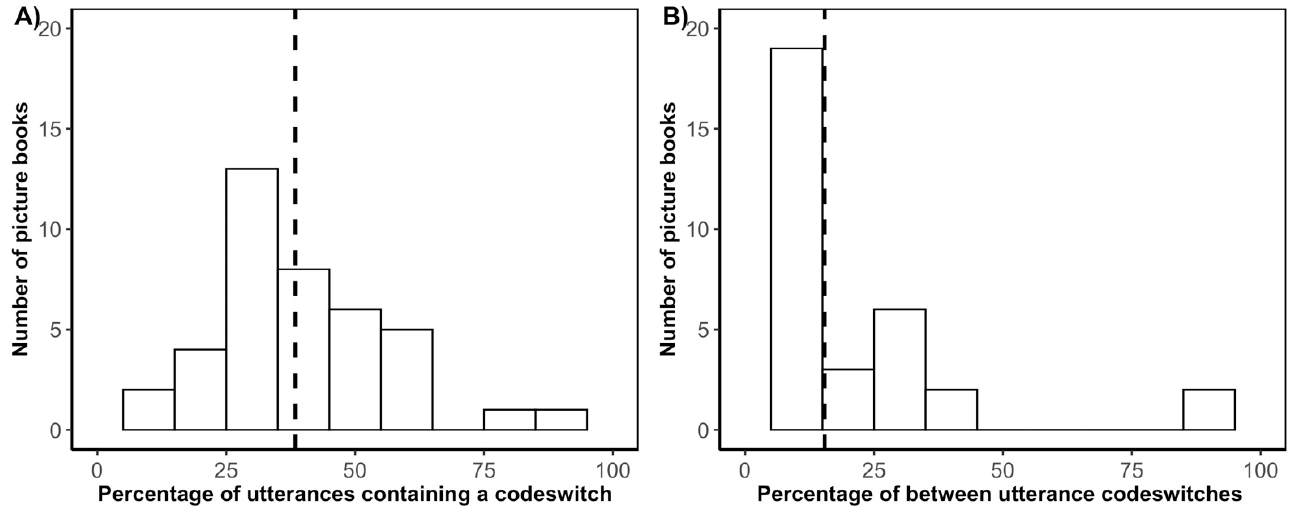
Figure 3. Histogram of ( A ) percent of utterances that contain both languages (within-utterance switches), and ( B ) percent of between-utterance switches. Dashed lines represent the sample mean. Further, mixed-language utterances presented more English word tokens ( M = 8.01, SD = 5.42) than Spanish word tokens ( M = 1.93, SD = 2.16), a difference that was significant